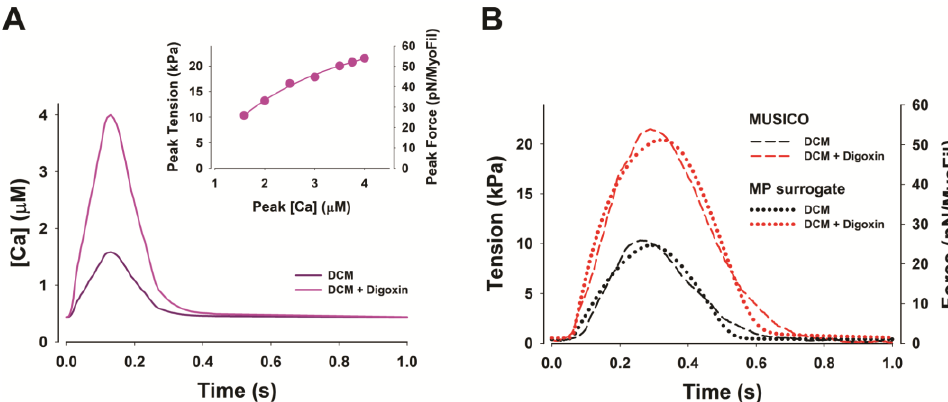
Figure 5. Digoxin effects on human DCM trabeculae twitch contraction. ( A ) Calcium transient for